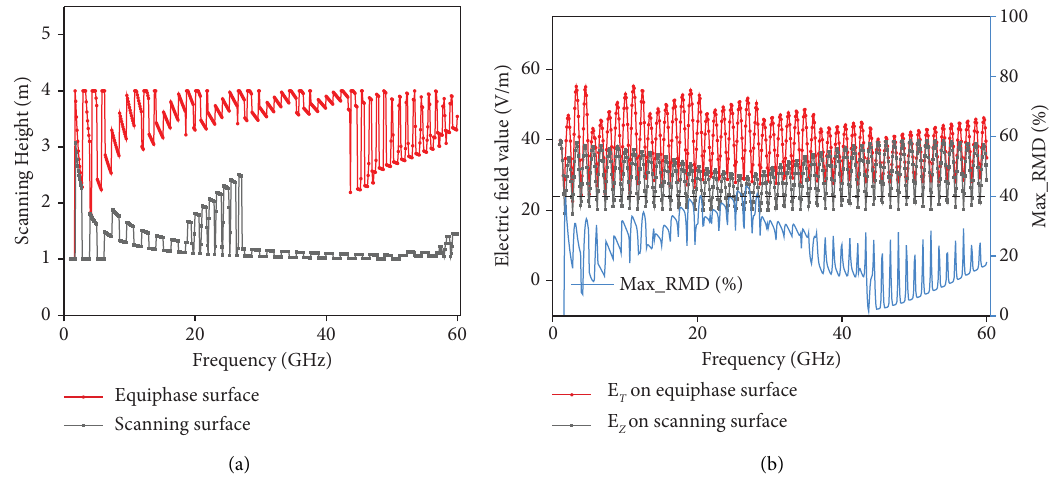
Figure 5: Results of a vertical dipole measured in a FAC: length h � 6U and distance d � 3 m. (a) Scanning height corresponding to the maximum electric felds on the two surfaces. (b) Relative deviation of the maximum electric felds on the two